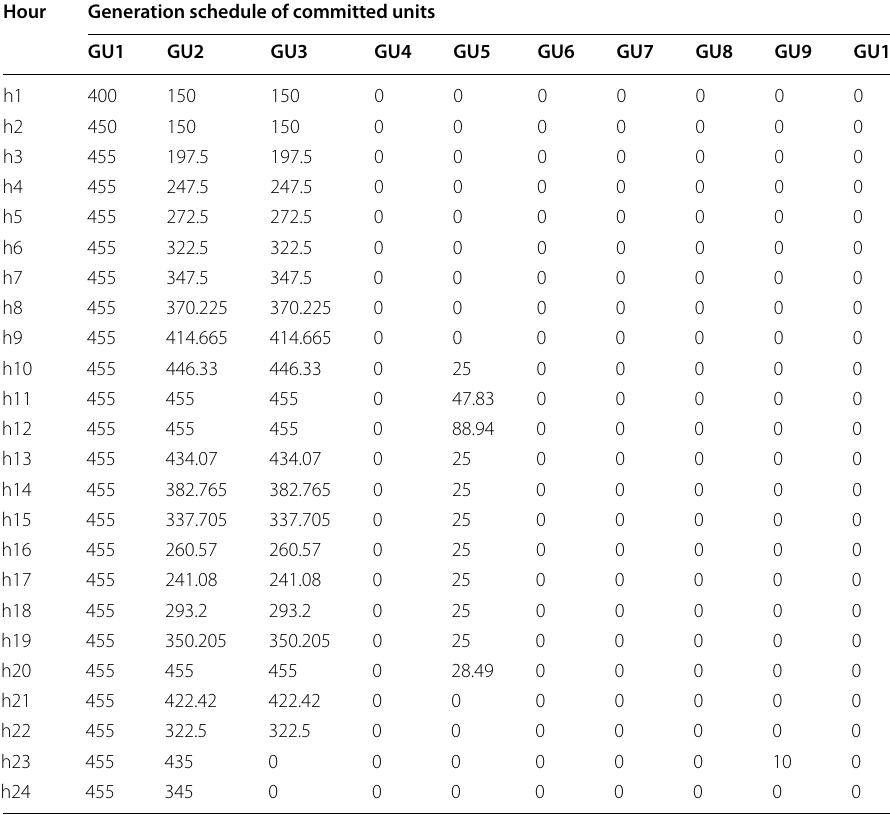
Table 4 Power scheduling for 10-generating unit system (5% SR) considering renewable energy in summer Hour Generation schedule of committed